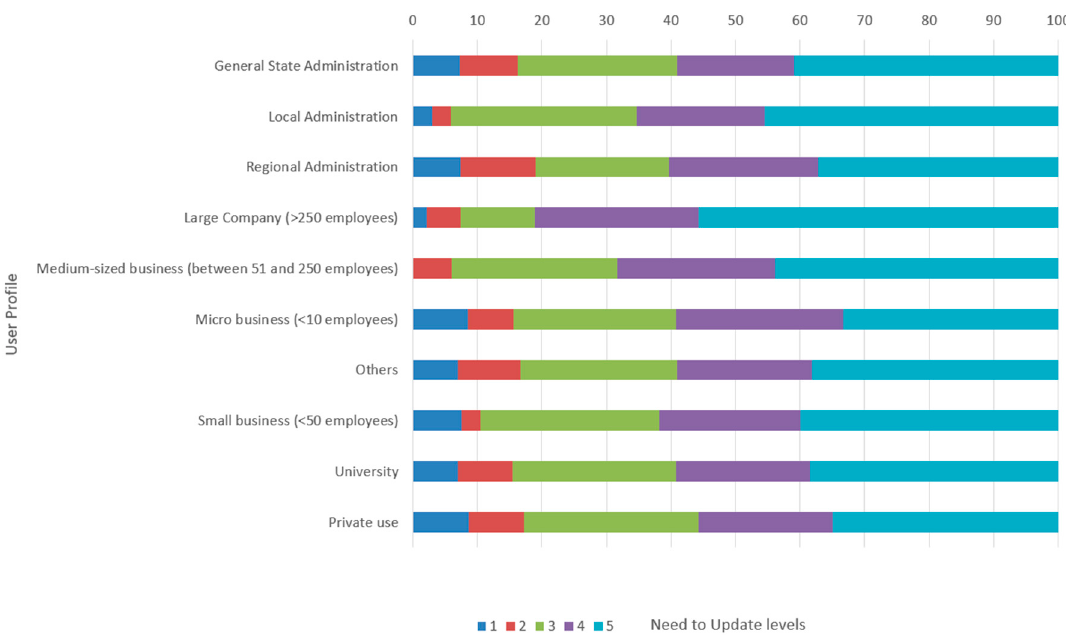
Figure 5. Percentage of the need to update levels assigned per user profile.